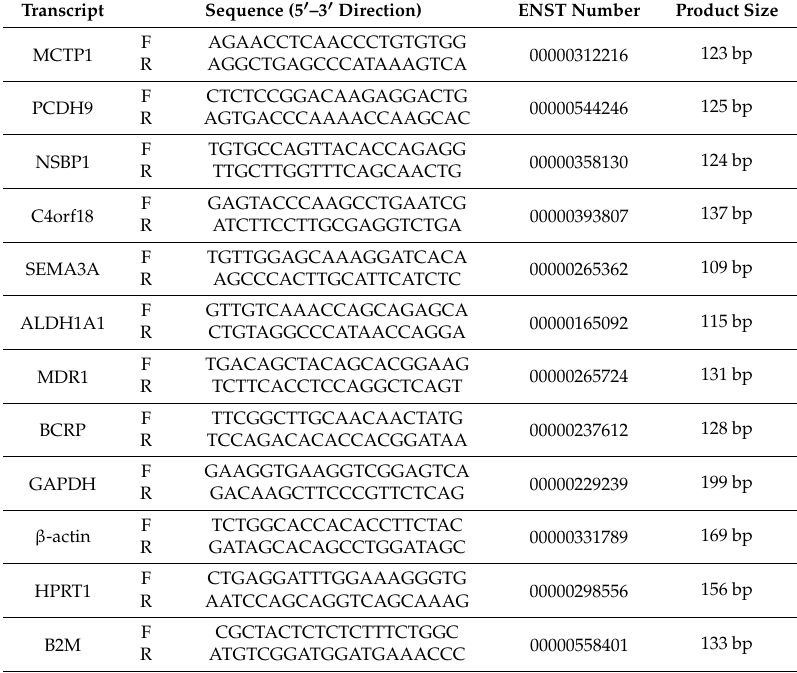
Table 1. Oligonucleotide sequences used for Q-PCR